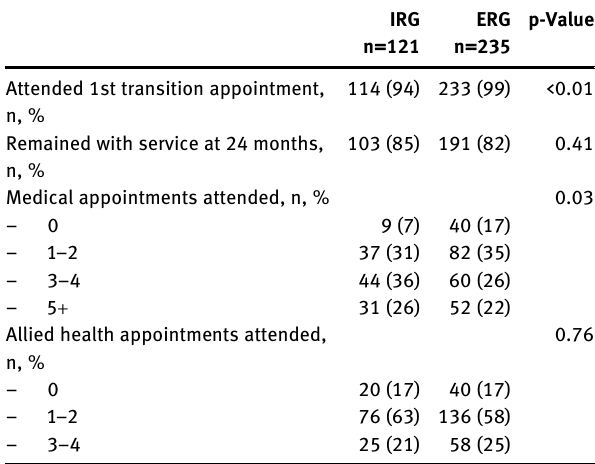
Table  : Diabetes care visit attendance.